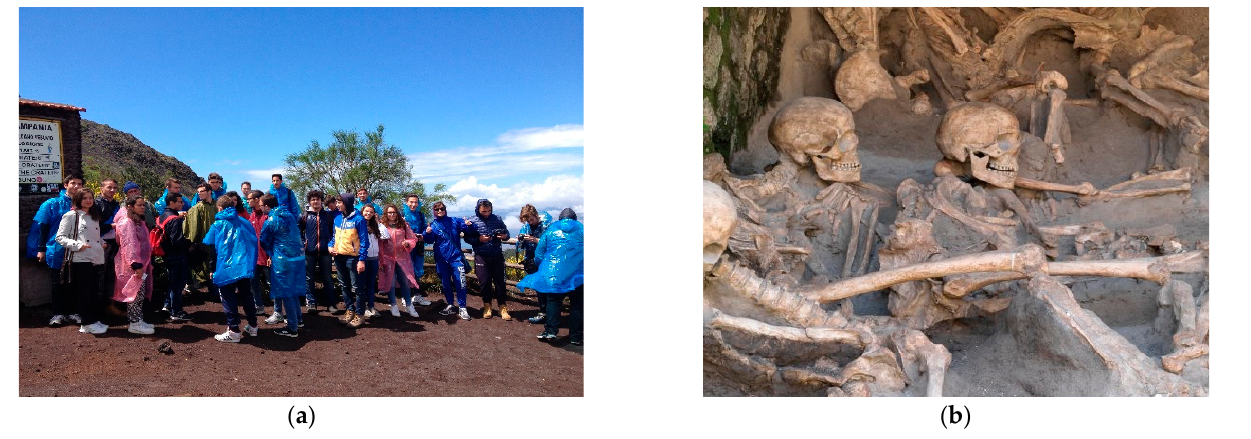
Figure 5. Two moments during the visit to the landscapes of the Neapolitan volcanic district (year 2018): ( a ) a moment of pause in the ascent to the crater of Vesuvius; ( b ) human skeletons of victims of the 79 A.D. volcanic eruption discovered in the Herculaneum excavations.